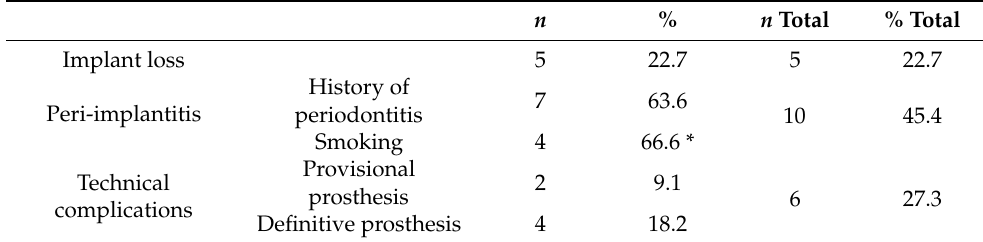
Table 3. Description of patients with